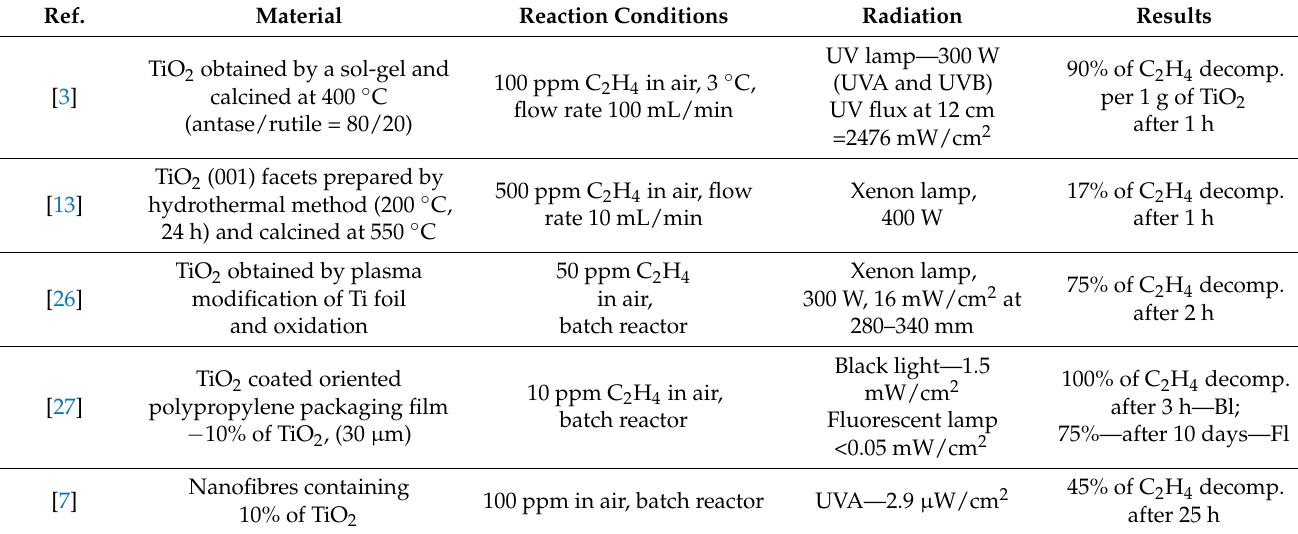
Table 5. Comparison of an ethylene decomposition on the different TiO 2